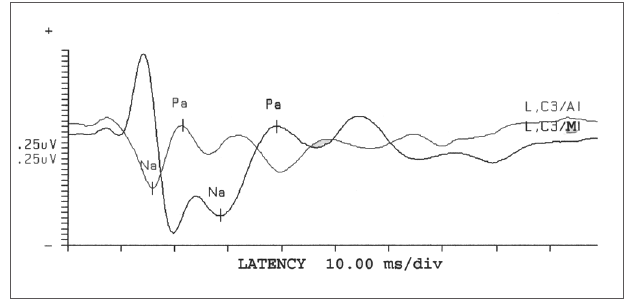
Figure 1. Presence and absence of myogenic response in face of sound stimulus in different electrode positions - L = left C3 = Left side temporoparietal junction A1 = Left earlobe M1 = Left